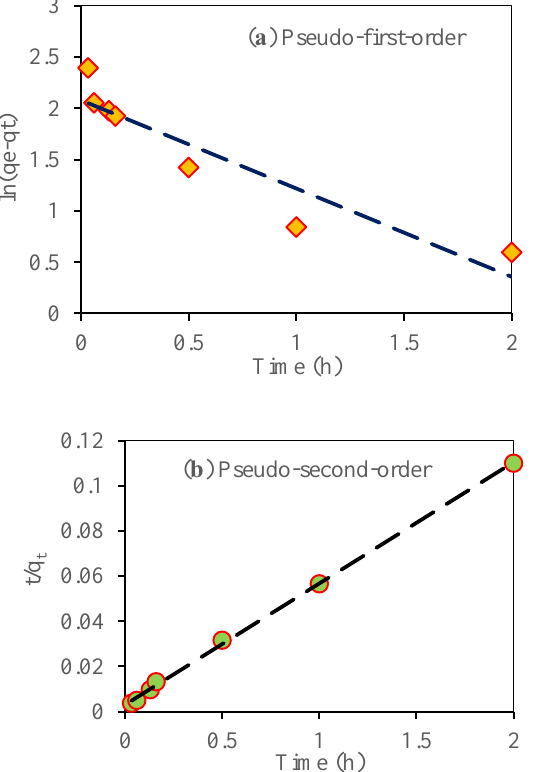
Figure 7. Adsorption kinetics (pseudo-first-order and second-order) of nitrate (initial concentration of nitrate was 60 mg L − 1 ). ( a ) Pseudo-first-order; ( b ) Pseudo-second-order.